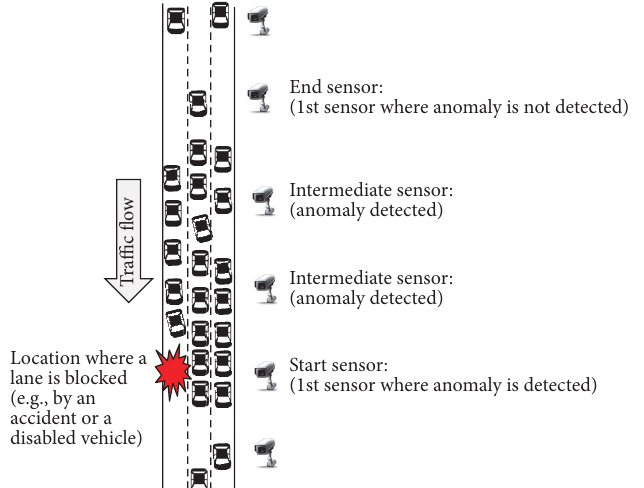
Figure 4: An illustration of how the proposed algorithm finds start, intermediate, and end sensors from speed patterns measured by roadside sensors. Start sensor is the first downstream sensor that detects an anomaly. End sensor is the first upstream sensor that an anomaly is not detected. Intermediate sensors are used to confirm that the congested area has extended upstream from start sensor to end